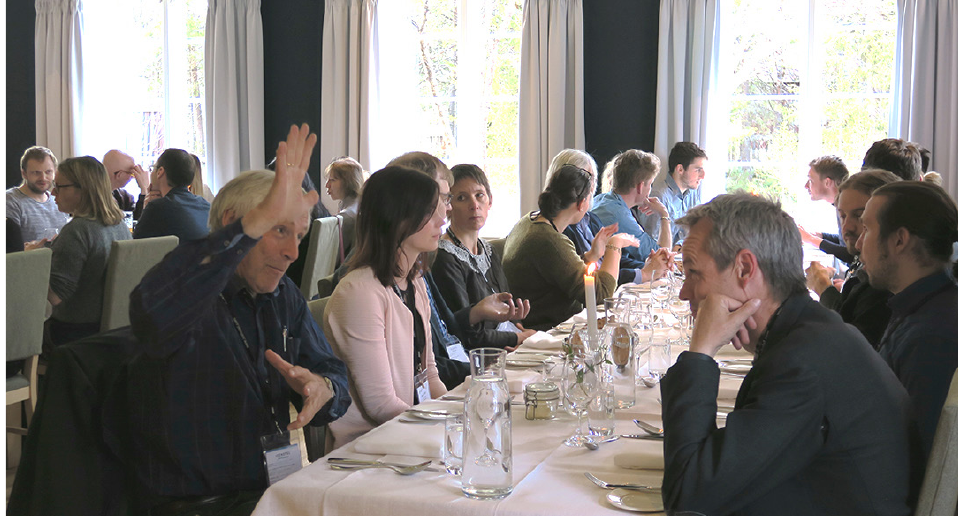
Fig. 3. A conference is a good opportunity to meet your colleagues. Here Hans Tømmervik (Norway) and Kjell Bolmgren (Sweden) are involved in a discussion at the dinner table (Photo: Hans Göran